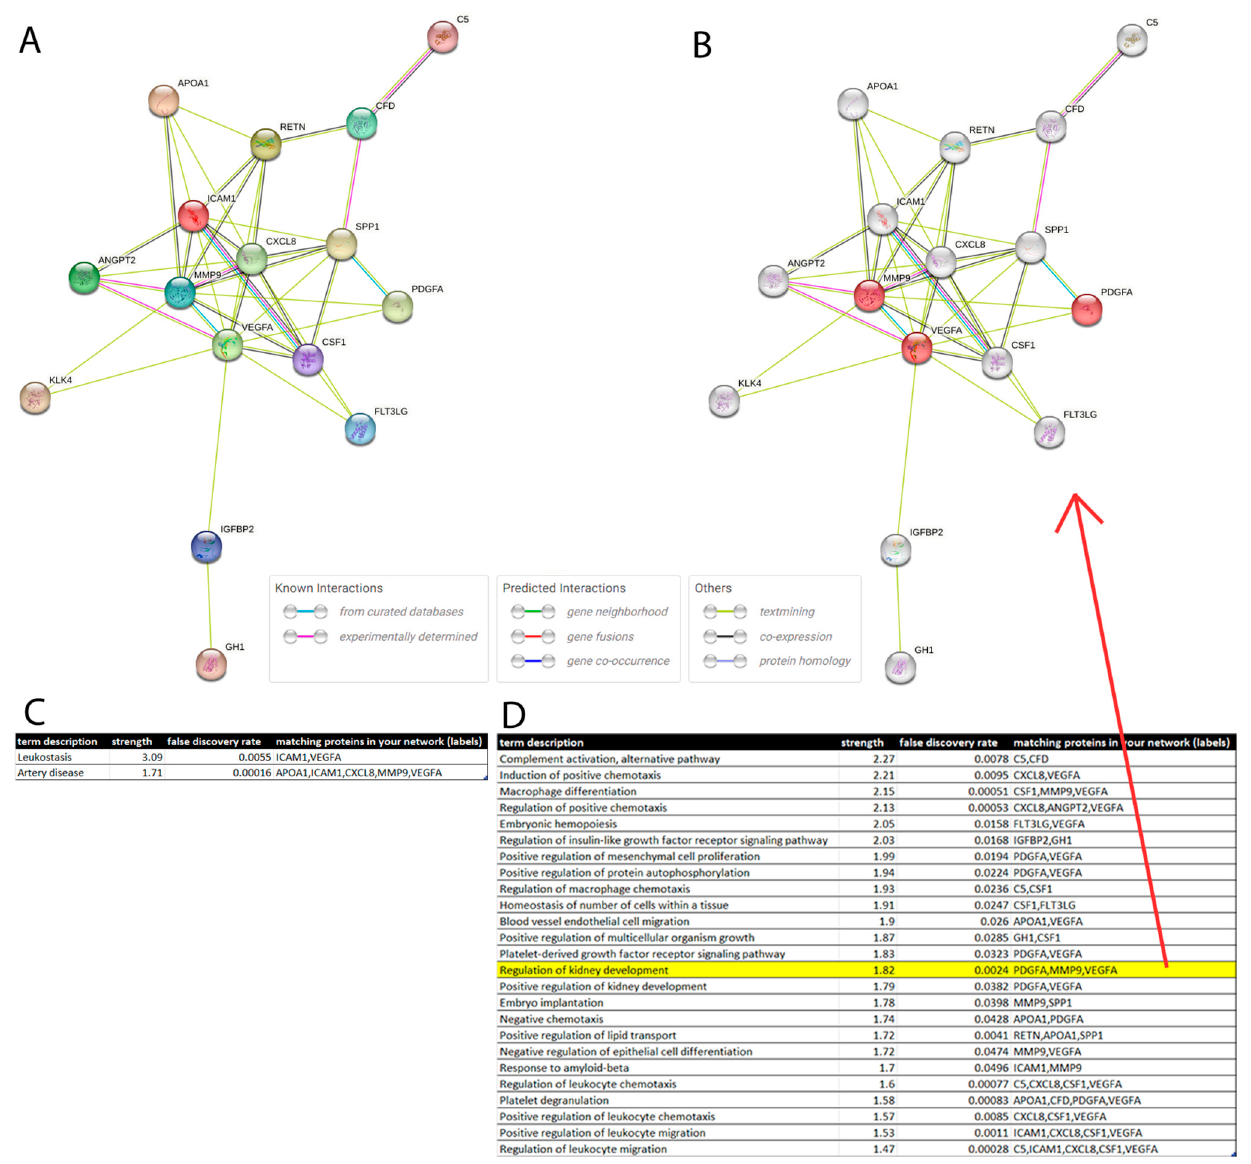
Figure 5. CKD biomarkers identified on the Human XL cytokine assay interact in a network regulating the inflammatory response affecting kidney development. ( A ) STRING protein interaction network (PPI) of CKD biomarkers identified on the Human XL cytokine assay. ( B ) PPI highlighting proteins involved in the regulation of kidney development. ( C ) Disease associations found enriched by the STRING tool are Leukostasis and Artery Disease . ( D ) Gene ontology Biological Processes found enriched point to the inflammatory response and include the regulation of kidney development